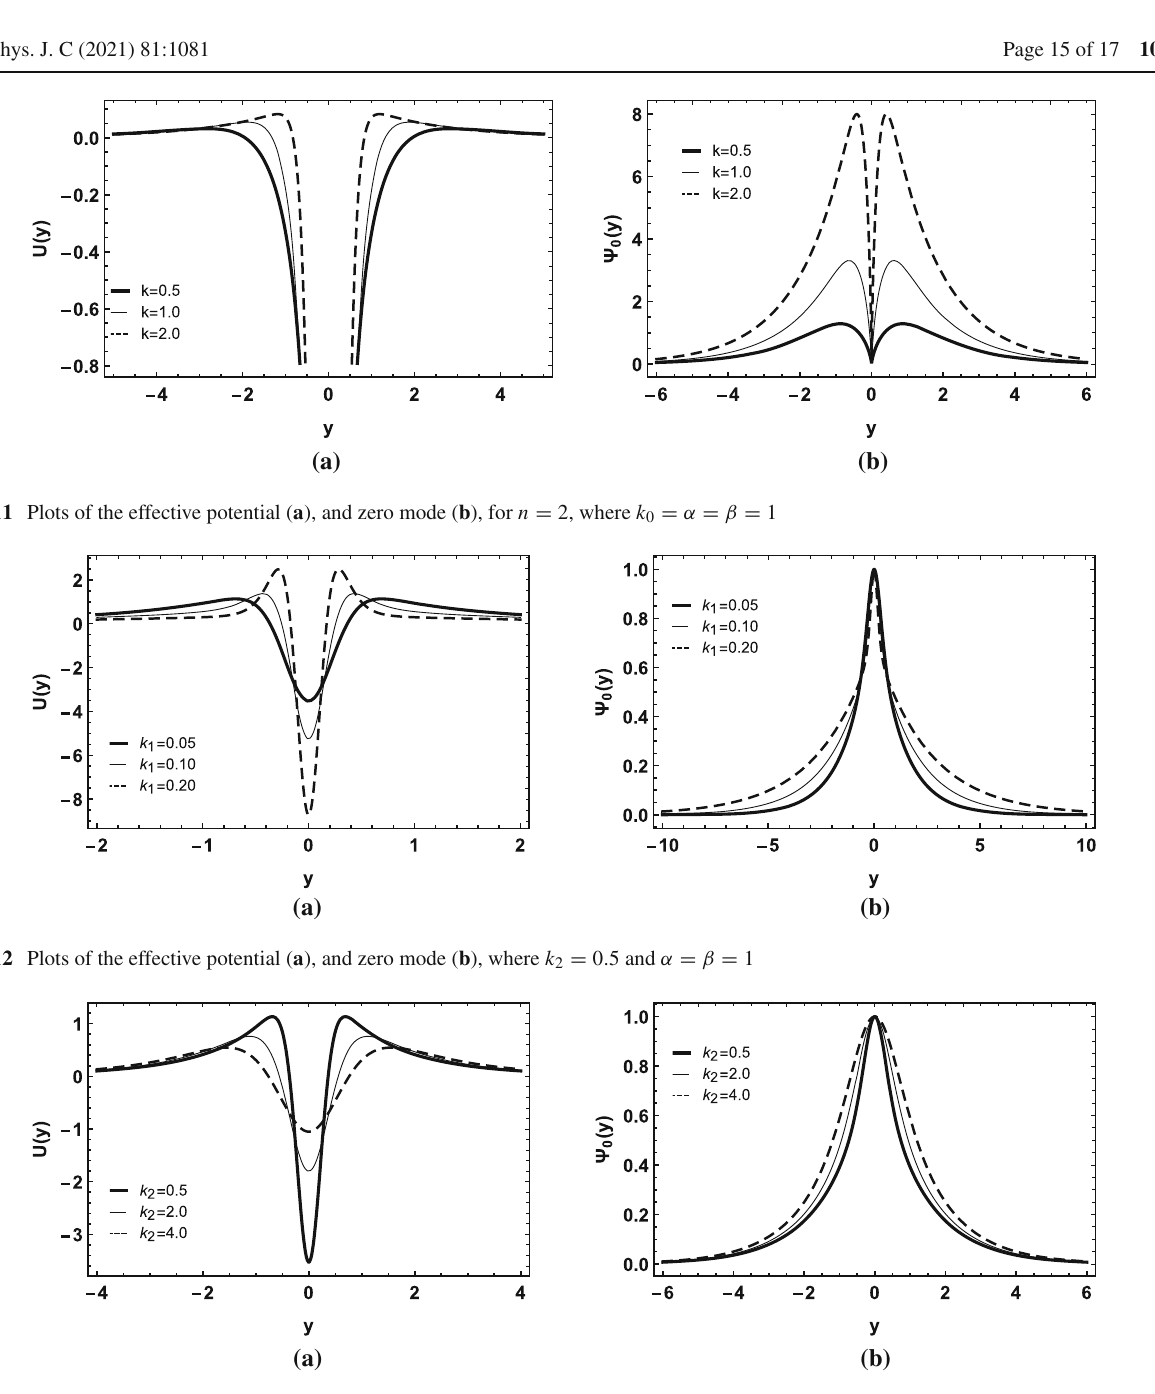
Fig. 13 Plots of the effective potential ( a ), and zero mode ( b ), where k 1 = 0 . 05 and α = β =